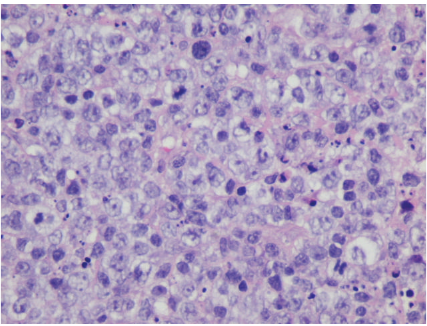
Figure 3: Infiltration of large lymphoid cells (haematoxylin and eosin stain, original magnification × 40).